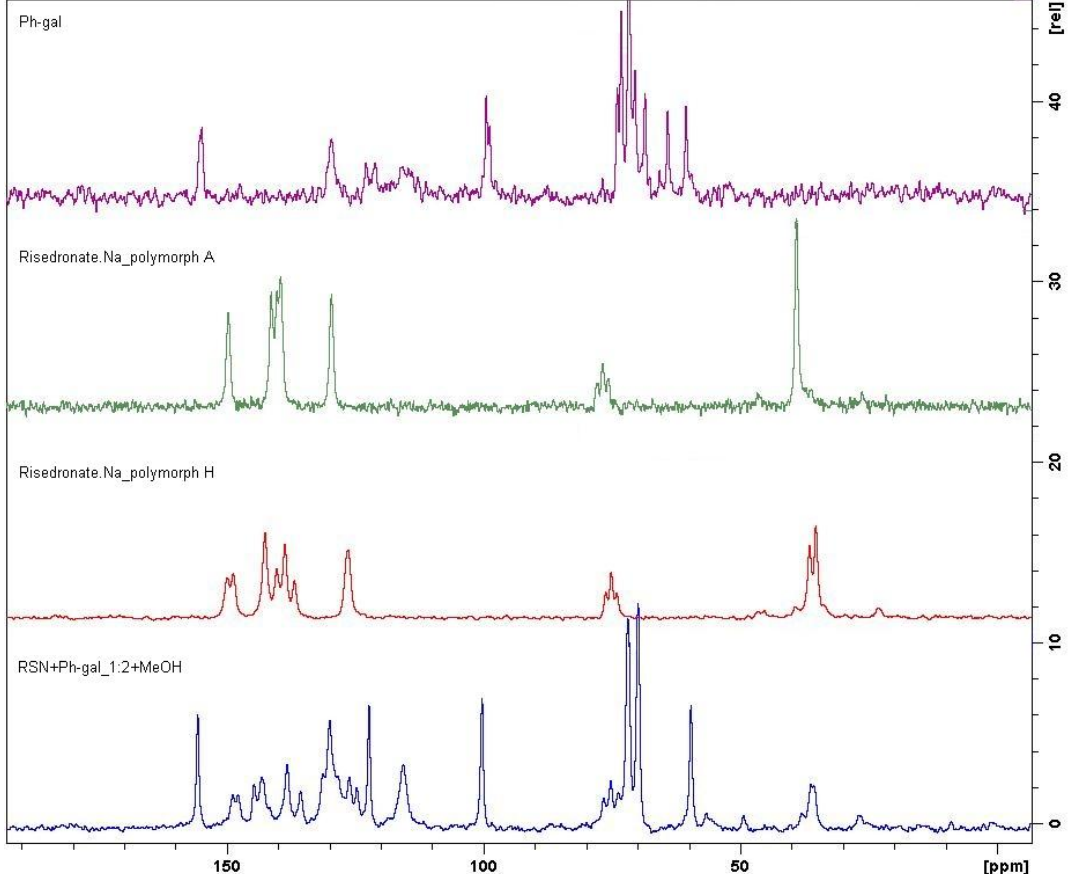
Figure 16. Comparison of 13 C CP/MAS NMR spectra of semi-crystalline risedronate monosodium salt (RSN), forms A and H and phenyl- β - D -galactopyranoside (Ph-gal) and spectrum of potentially new crystalline form (sample 6 ).